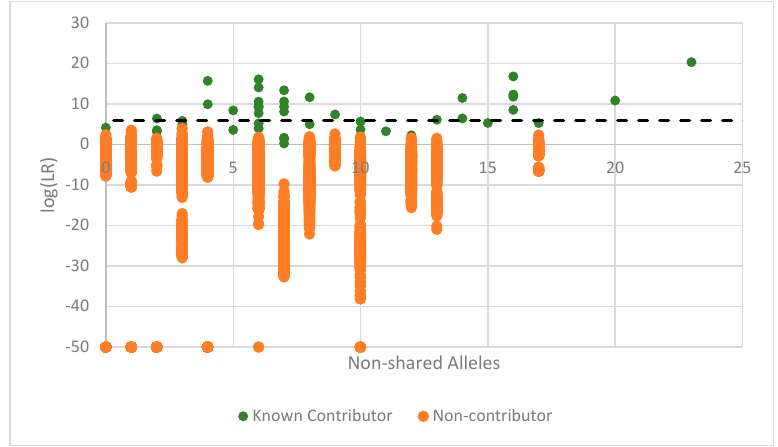
Figure 11. Specificity of DSCS (EFM) mini-mixture analysis. EuroForMix; Single source subsamples. LR = 0 plotted as − 50. Green circles (known contributors), orange circles (non-contributor).